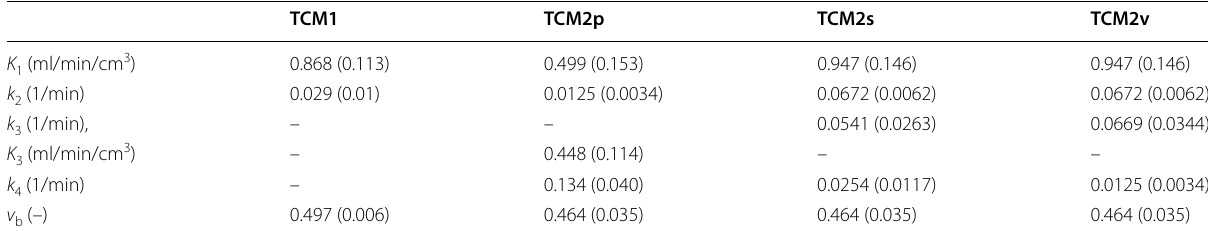
Table 2 Fit parameters of four-compartment models for [ 11 C]mHED myocardial uptake in mice (mean of 3 independent scans, SD in parentheses)